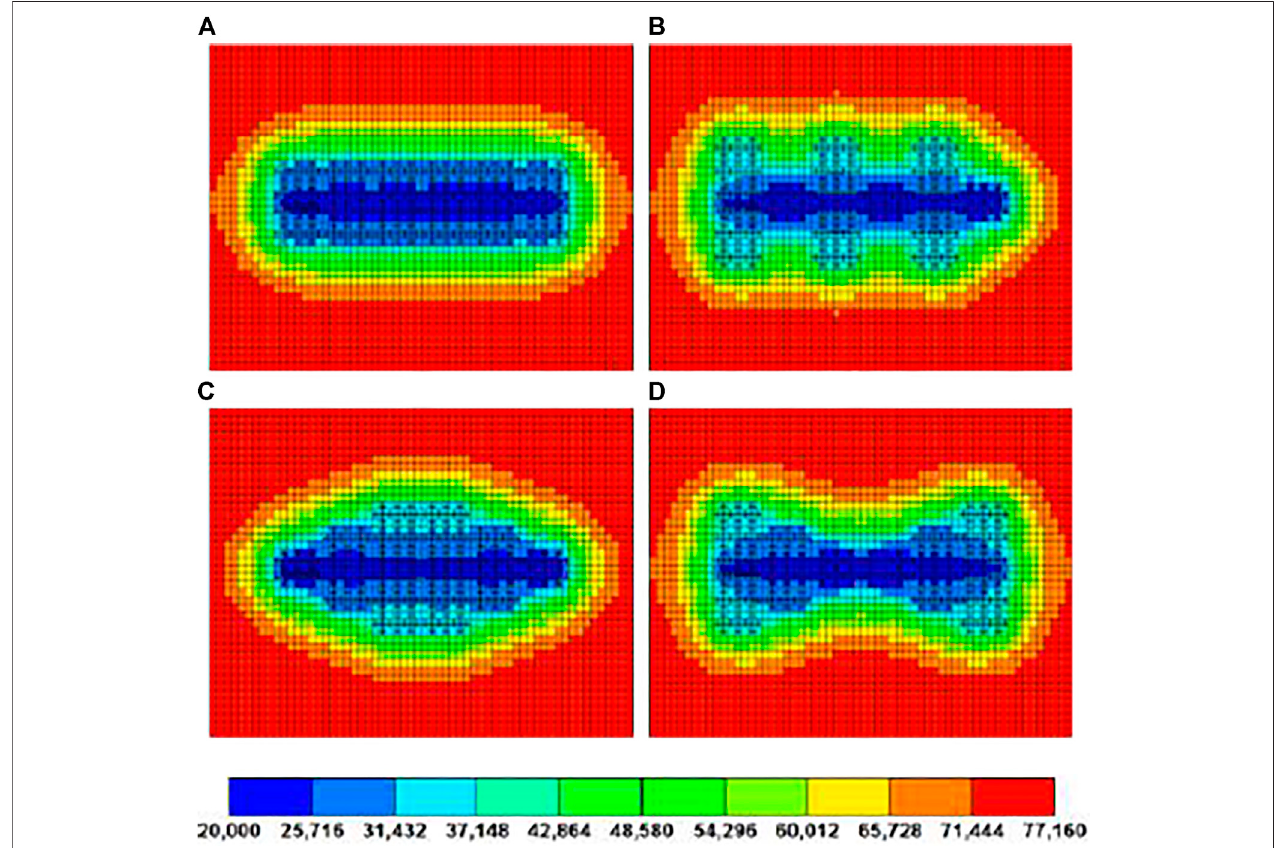
FIGURE 14 | Pressure distribution map of horizontal wells with different fracture laying patterns.